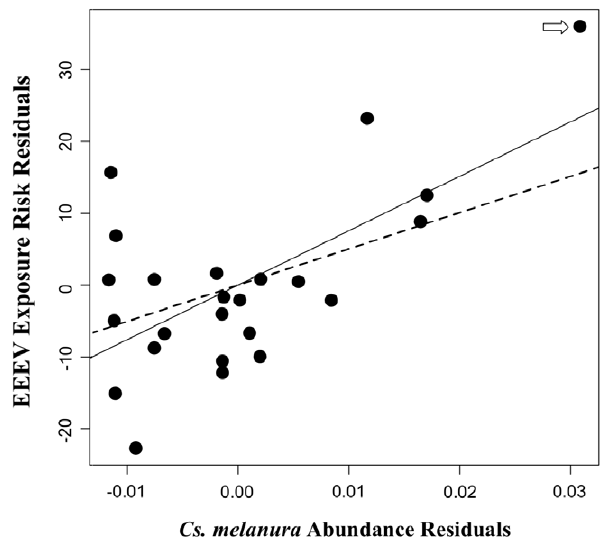
Figure 4. Association between EEEV exposure and Cs.melanura abundance. Added-variable plot showing the relationship between EEEV exposure risk in chickens during 2009 and 2010 and Culiseta melanura abundance at 24 sentinel sites in Walton County, Florida. The estimate for the slope of EEEV exposure risk regressed on Cs. melanura was 0.0028 with a 95% UCI of ( 2 0.0012, 0.0058). Cs. melanura abundance residuals=residuals from regression of northern cardinal density on Cs. melanura abundance, EEEV exposure risk residuals=re- siduals from regression of EEEV exposure risk residuals on Cs. melanura abundance. The best-fit line from simple linear regression of EEEV exposure risk residuals on northern cardinal density residuals are overlaid, with the solid line fit to the full dataset, and the dashed line fit to the dataset that excluded the influential observation shown in Figure 3.